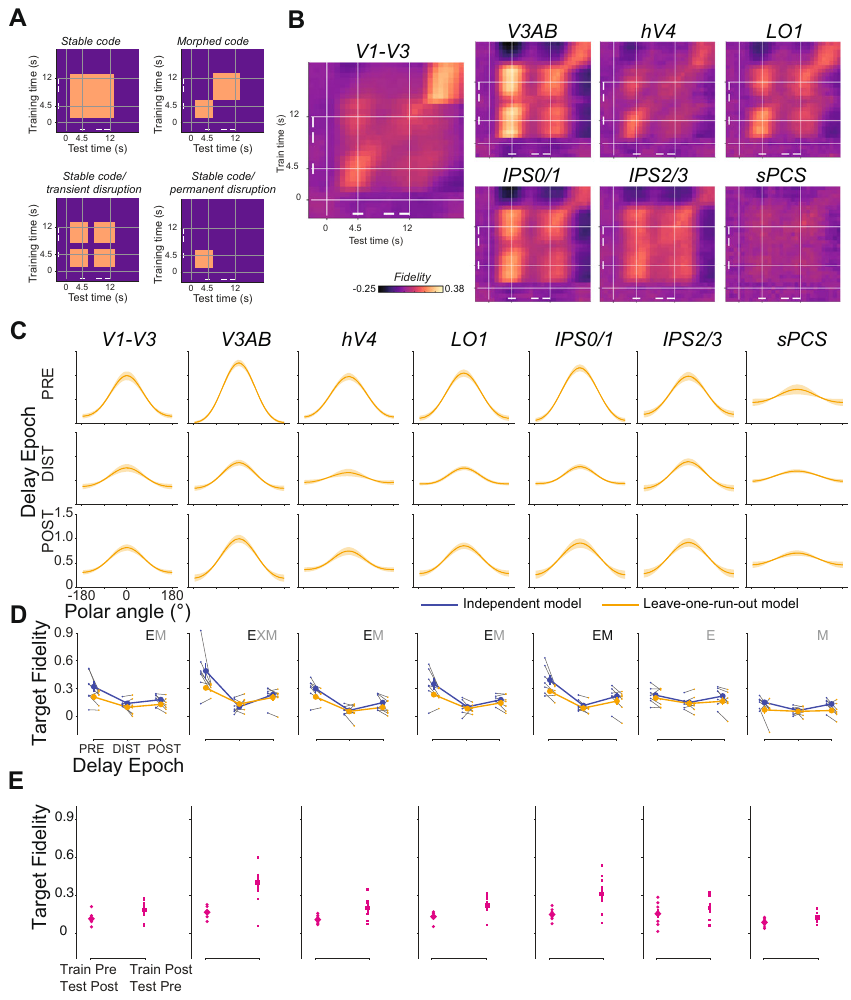
Fig. 6 Loss of WM fi delity during distraction cannot be explained by a different coding format. A To evaluate the format of WM representations throughout distractor-present trials, we conducted a temporal generalization analysis using distractor-present trials to estimate an IEM (each timepoint in turn) which was used to reconstruct held-out distractor-present trials (each timepoint in turn; leave-one-run-out cross-validation). For each combination of training and testing timepoints, we compute the WM target representation fi delity. Four cartoon examples illustrate predicted results from this analysis under various (non-exhaustive) coding schemes. B Fidelity is strong across a large combination of training/testing timepoints during the delay period with no evidence of a transition to a new coding format during or after the distractor. In many ROIs (e.g., V3AB), results are consistent with a transient disruption in WM representation, but no change or morphing in representational format following distraction. White bars indicate epochs used for analyses in C , D . C Model-based reconstructions from a cross-temporal generalization analysis in which training and testing was performed on corresponding epochs of the delay (i.e., train IEM with PRE timepoints, reconstruct using PRE timepoints from trials in held-out run). Rows show reconstructions from each ROI from each epoch (error bars ±SEM). Qualitatively, a substantial dip in WM reconstruction strength is apparent during the DIST epoch, as in Fig. 5A. D Comparison of group mean (error bars ±SEM) fi delity during each trial epoch across model estimation procedures. Blue line shows data computed using an independent model (replotted from Fig. 5B); orange line shows data computed using the leave-one-run-out cross-validation procedure. Gray lines connect datapoints from individual participants ( n = 7). We performed a 2-way repeated-measures ANOVA against a shuf fl ed null for each ROI (factors model and trial epoch). Main effects of model are indicated by M, main effects of epoch are indicated by E, and interactions are indicated by X. Signi fi cant tests are shown in black ( p < 0.05, FDR corrected across ROIs within test); trends are shown in gray ( p < 0.05, no correction). Error bars ±SEM. No ROIs show a signi fi cant interaction between model and epoch (though a trend is seen in V3AB, which is largely driven by stronger WM target representations measured using the independent model). E Comparison of off-diagonal training/testing combinations, (group mean, error bars ±SEM, derived from n = 7 participants). To determine if models trained and tested on non-matched epochs were able to recover information, we measured fi delity from models trained on PRE and tested on POST, as well as trained on POST and tested on PRE delay epochs. All p ’ s < 0.05 when comparing each average fi delity against a null distribution of fi delity values computed as in Fig. 4. Data from all individual ROIs available in Supplementary Fig. 5; p -values for all tests available in Supplementary Table